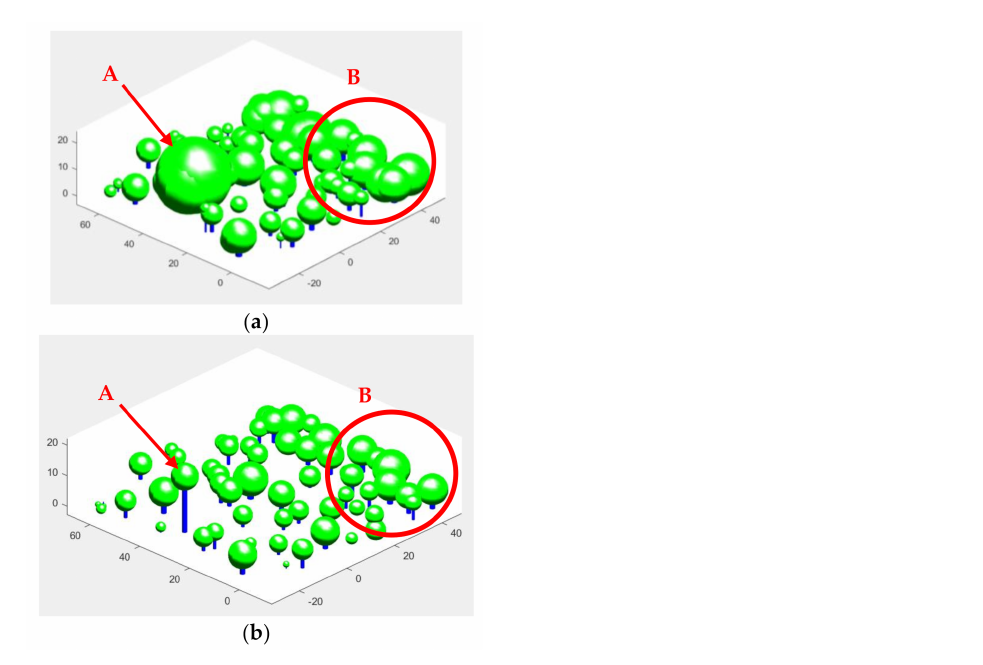
Figure 16. Differences in tree crown radius from the modeling results of individual tree ( A ) and group of trees ( B ) with the sphere method on ( a ) photogrammetry data and ( b ) LiDAR data.